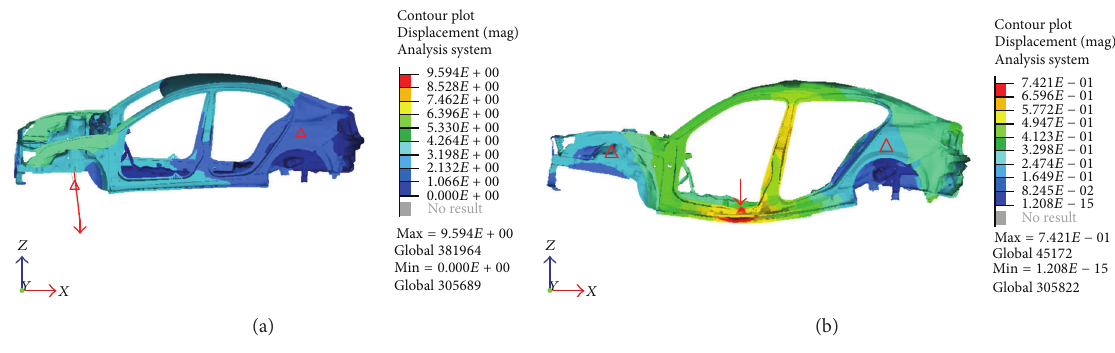
Figure 3: Static torsion (a) and bending (b)